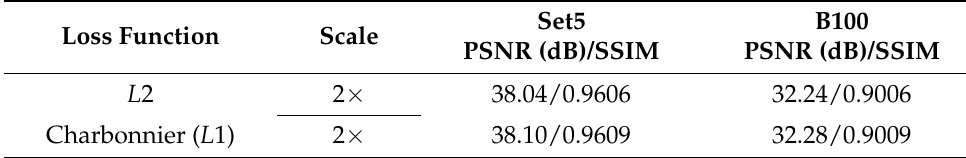
Table 6. The performance of models trained with different loss functions.